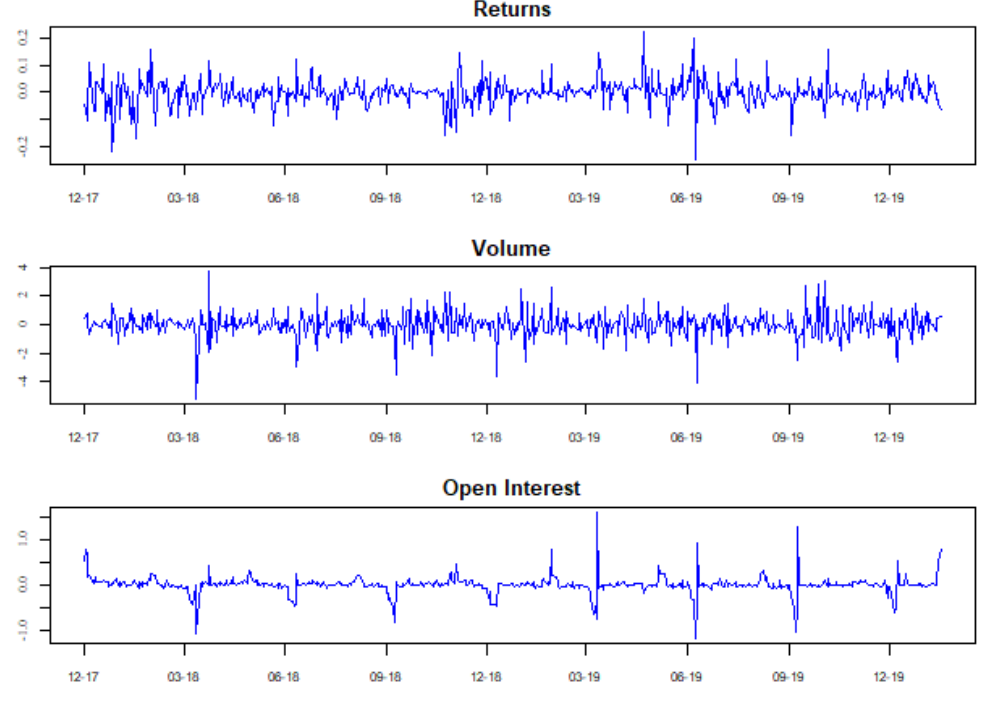
Figure 1. Bitcoin futures contracts returns, volume, and open interest